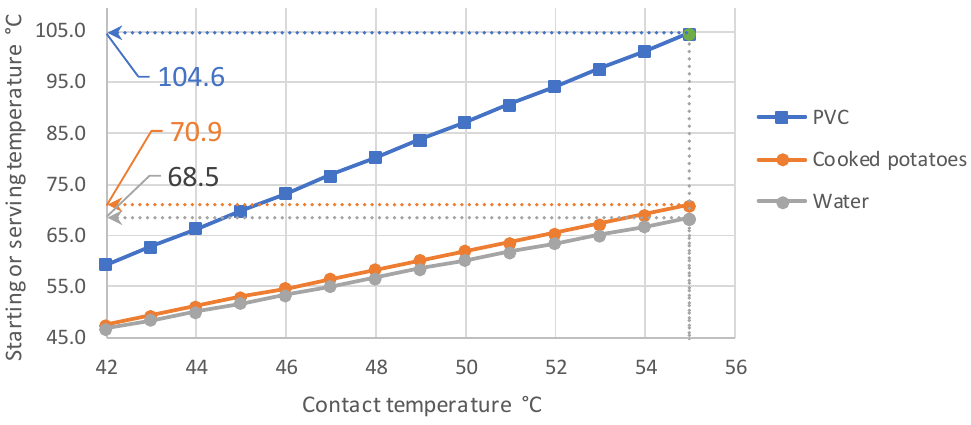
Figure 5. Starting and consumption temperatures as a function of the contact temperature.